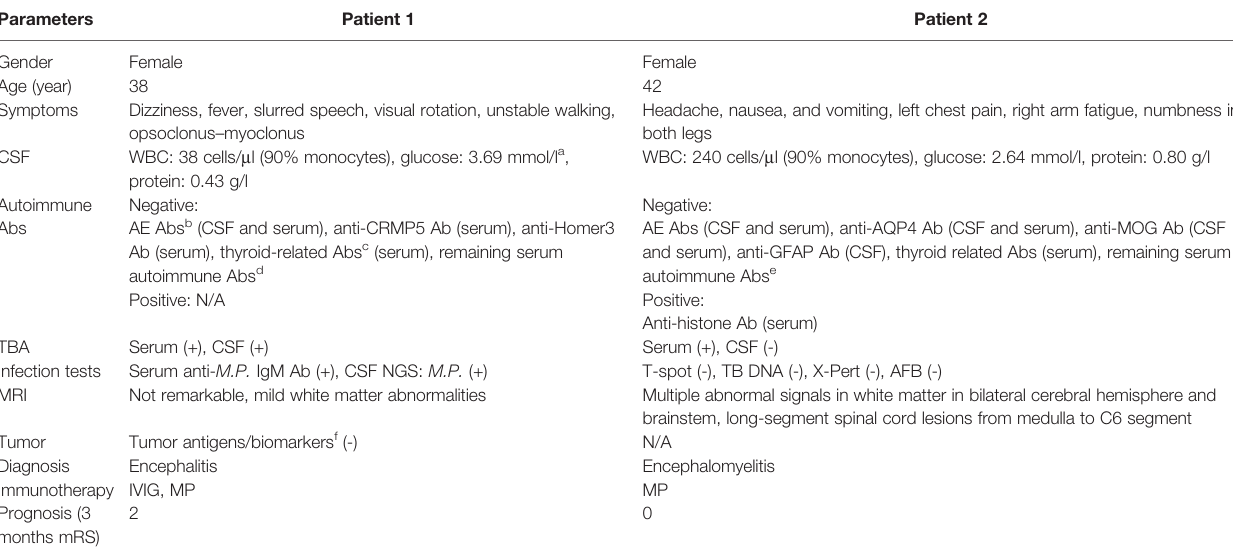
TABLE 1 | Clinical features of the patients with anti-CRMP2 antibodies.